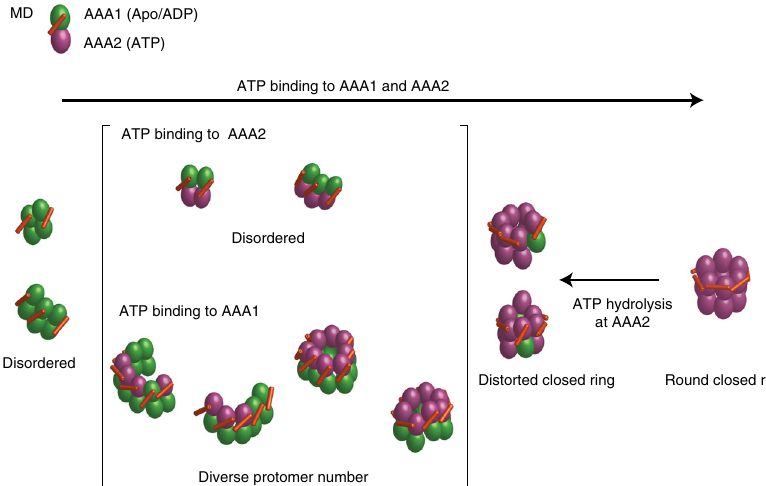
Fig. 5 Schematic model of oligomeric structures and structural dynamics of ClpB. Green and purple colors of the AAA modules indicate the ADP/Apo state and the ATP bound state, respectively. ATP binding to AAA1 is essential for assembly into oligomers but insuf fi cient to form ring-shaped hexamers. ATP binding to AAA2 regulates and adjusts the number of subunits in an oligomer to six (hexamer), and arranges MD in a horizontal con fi guration, resulting in round closed hexamers. ATP hydrolysis at AAA2 disrupts the inter-subunit interaction to form distorted closed hexamers in which some MDs are tilted. ATP hydrolysis on AAA1 possibly contributes to increasing the coupling ef fi ciency of ATP hydrolysis on AAA2 and the structural